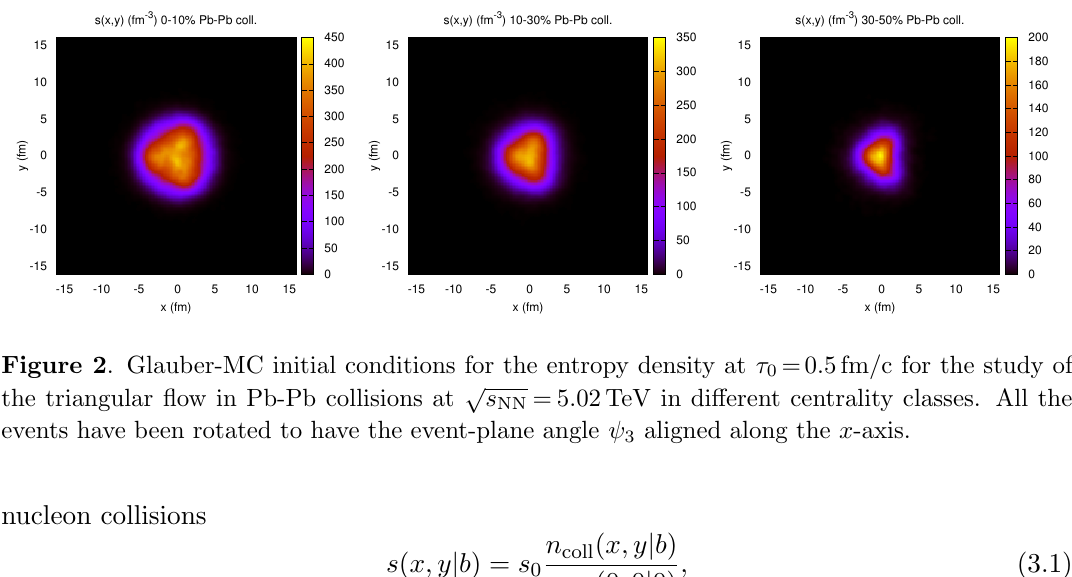
Figure 1 . Glauber-MC initial conditions for the entropy density at (cid:28) 0 =0 : 5 fm/c for the study of p the elliptic (cid:13)ow in Pb-Pb collisions at s NN =5 : 02 TeV in di(cid:11)erent centrality classes. All the events have been rotated to have the event-plane angle 2 aligned along the x -axis.